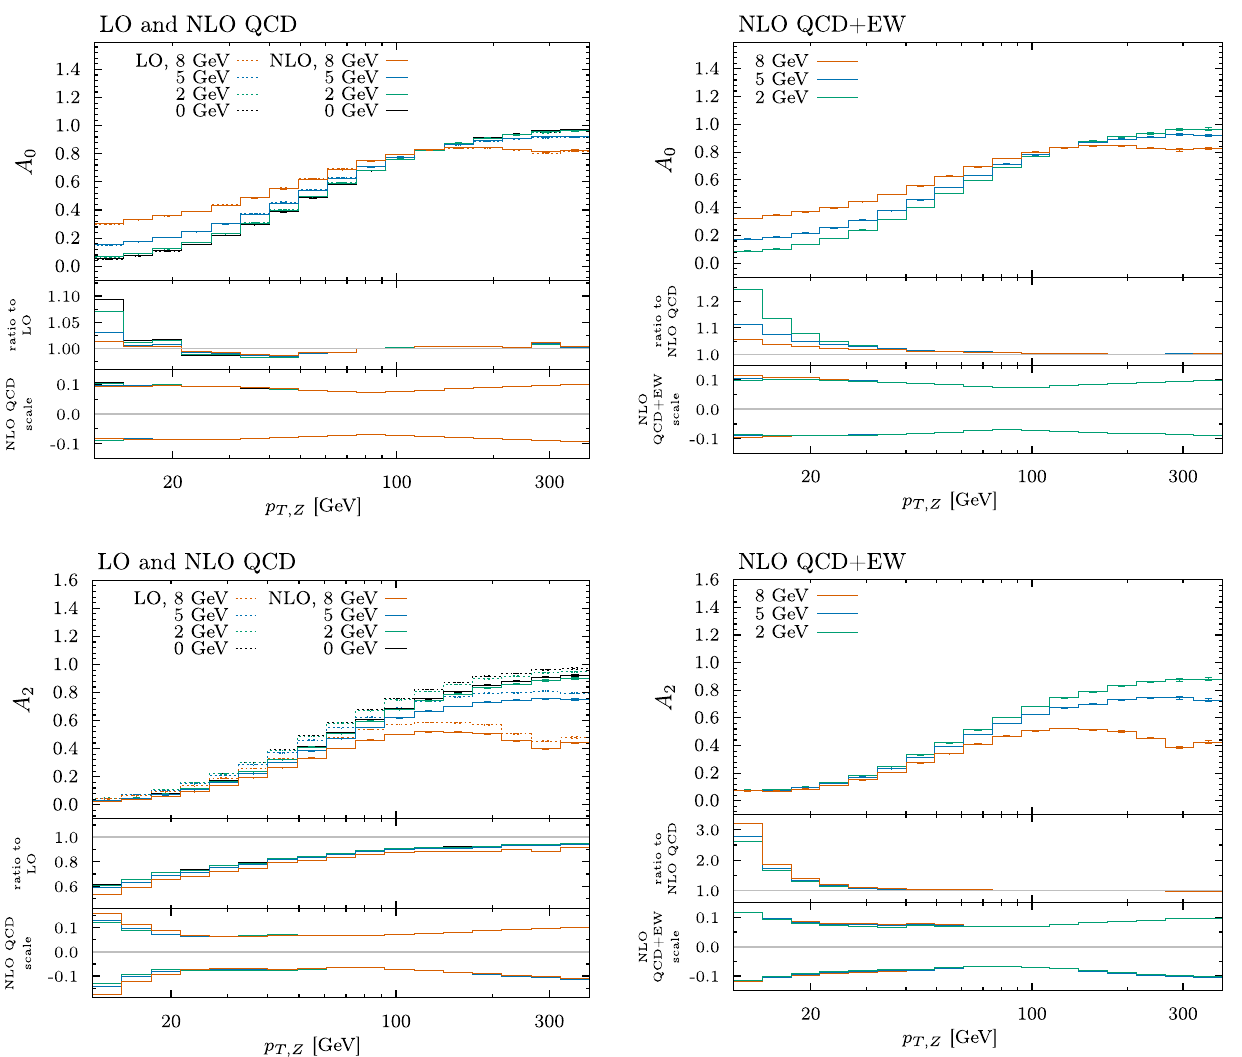
Fig. 2 The two largest angular coefficients A 0 (top) and A 2 (bottom), the LO and NLO QCD (left) and the NLO QCD + EW contribution (right) with corresponding ratios and scale uncertainties. The four (left)